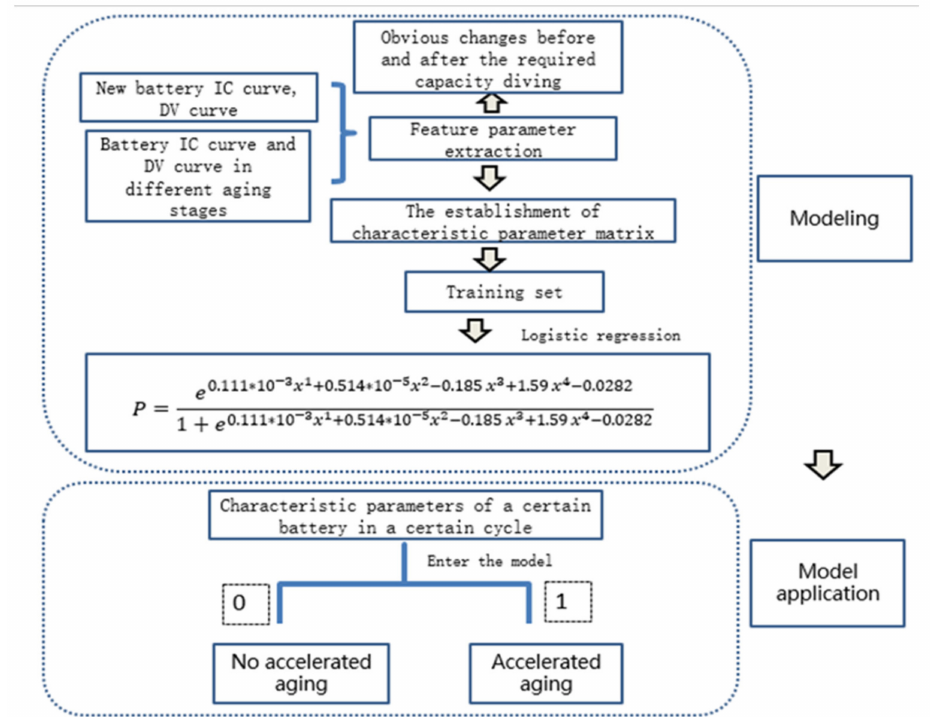
Figure 7. Flow chart.